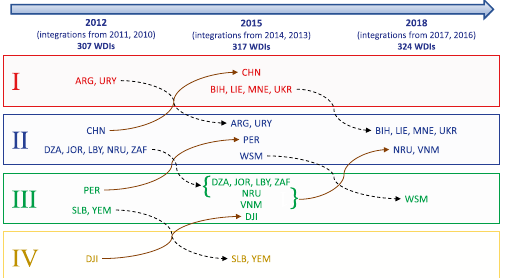
Figure 2. Variations in the membership of the four WDI communities from the 2012 network to the 2018 network.